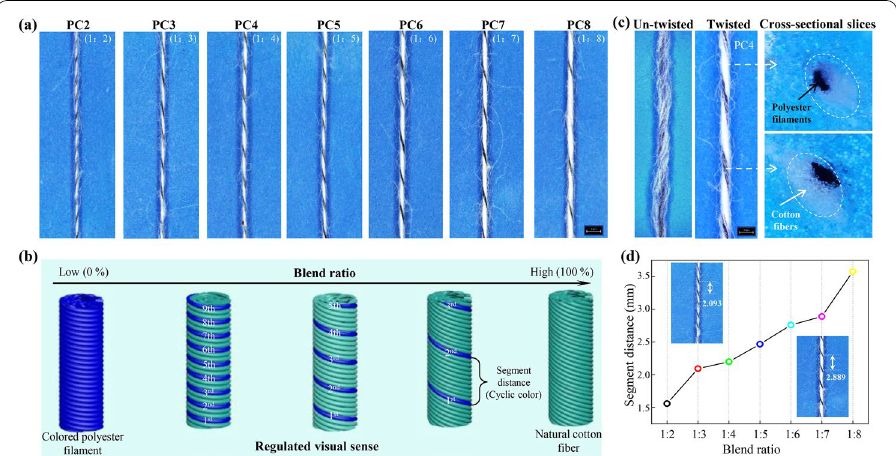
Fig. 2 a Optical images of the composite yarns prepared with varied blend ratios. b Schematic illustration of the blend ratios induced structural changes and regulated visual sense. c Optical observations of the segmented structure at different twisted states and regions. d Segment distance as a function of bending ratios